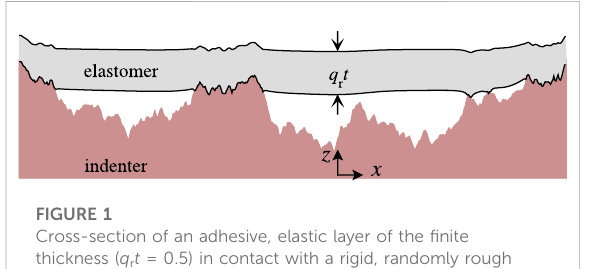
FIGURE 1 Cross-section of an adhesive, elastic layer of the fi nite thickness ( q r t = 0.5) in contact with a rigid, randomly rough substrate. The shown cross-section, which contains the highest point of our default topography, is not to scale.